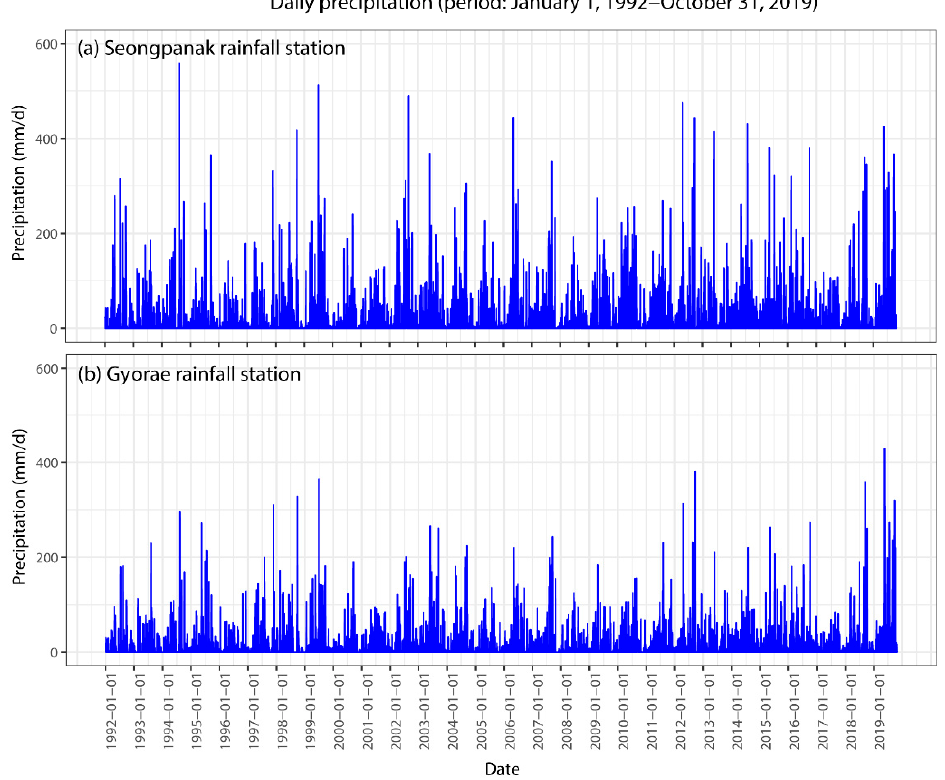
Figure 2. Comparison of daily precipitation in Seongpanak and Gyorae rainfall stations.